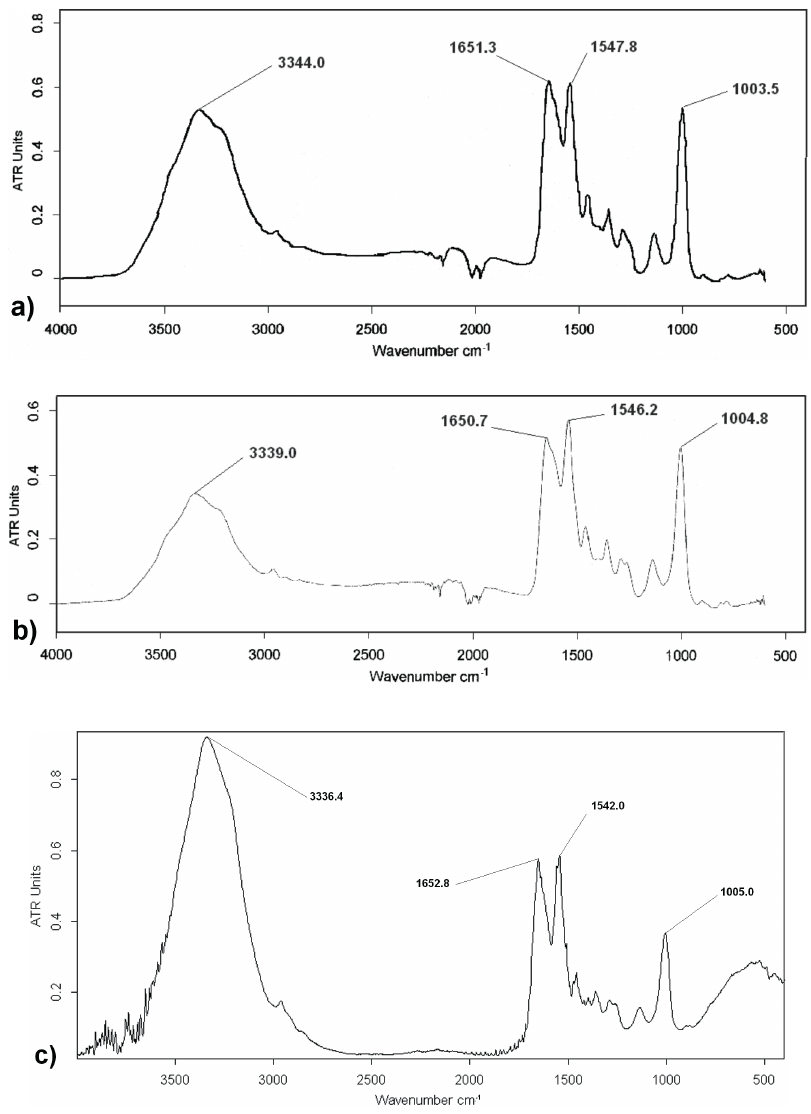
Figure 8: FT-IR spectra of urea-formaldehyde precondensate for U/F a) 1/1; b) 1.5/1; c)